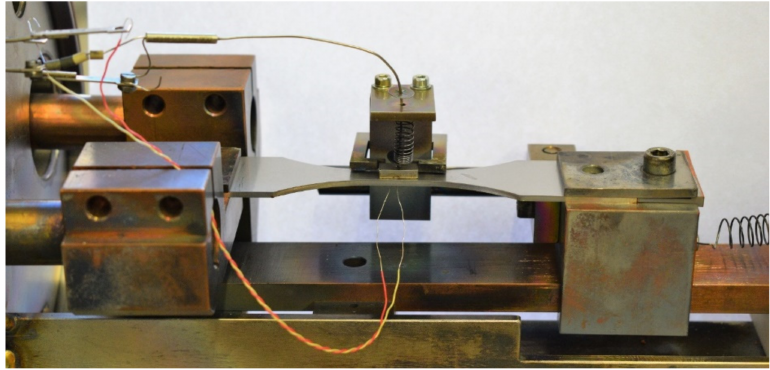
Figure 4. Conductive brazing test stand developed at Technical University